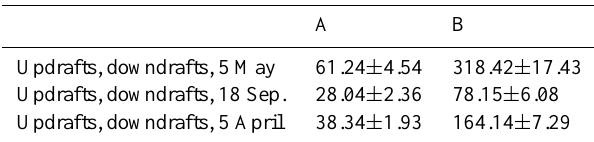
Table 2. Fit parameters ( ± standard deviation) describing the ex- ponential curves in Fig. 9. The function is N d = A exp ( − d/B) with the number of updrafts or downdrafts N d and horizontal extent d .